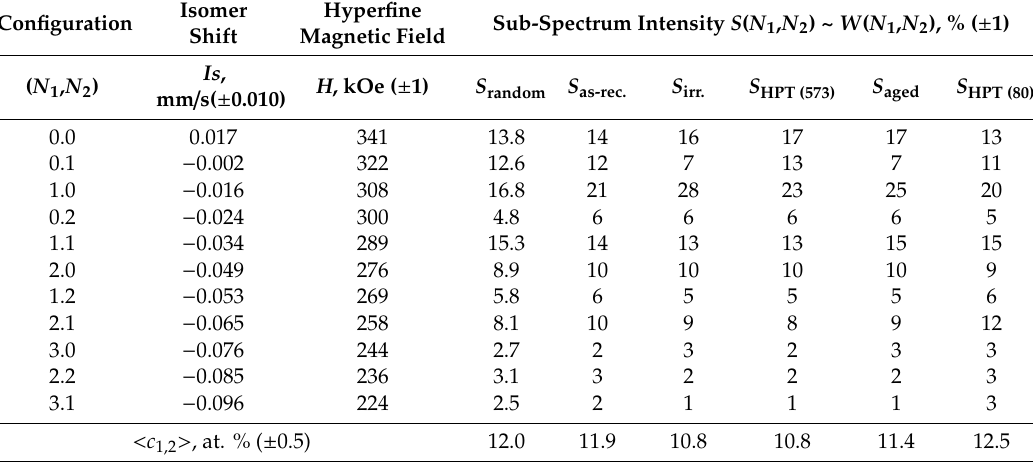
Table 2. Hyperfine Mössbauer parameters, intensities S ( N 1 , N 2 ) of subspectra and < c 1,2 > for the Fe 86.8 Cr 13.2 alloy in di ff erent states: S random –theoretical; S as-rec. –as received; S irr. –irradiated; S HPT (573) –HPT at 573 K; S aged –aged at 773 K, 50 h; S HPT (80) –aged and HPT at 80